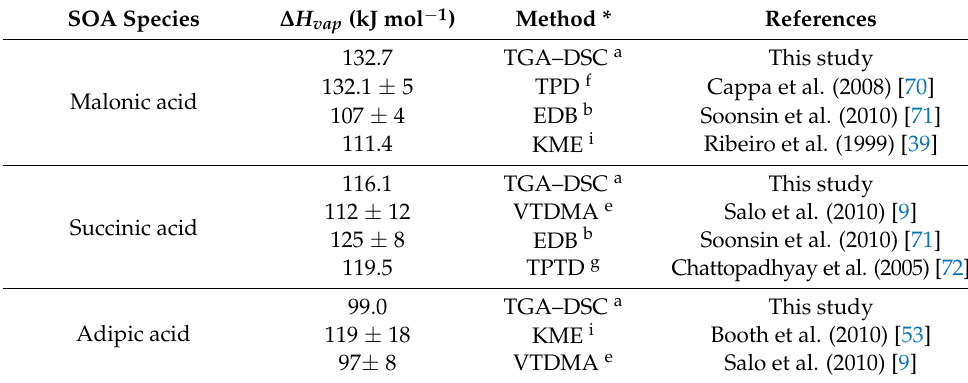
Table 3. Vaporization enthalpies of biogenic and anthropogenic SOA species.